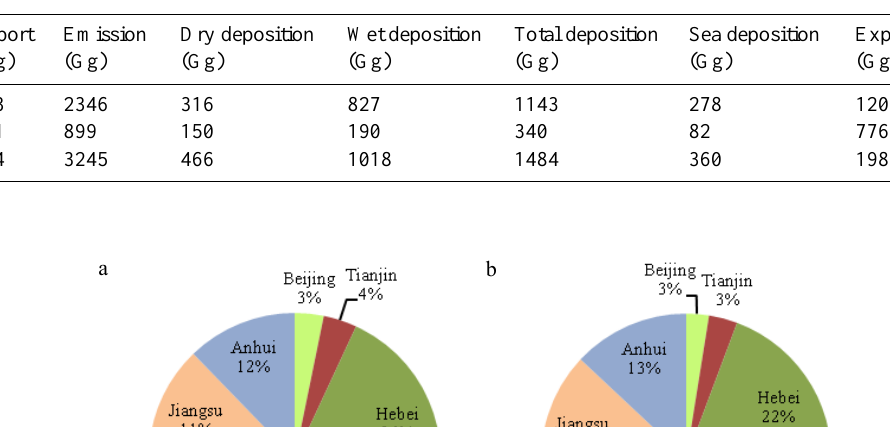
Table 1. Mass budgets of emission, import, export and deposition of N in the NCP.